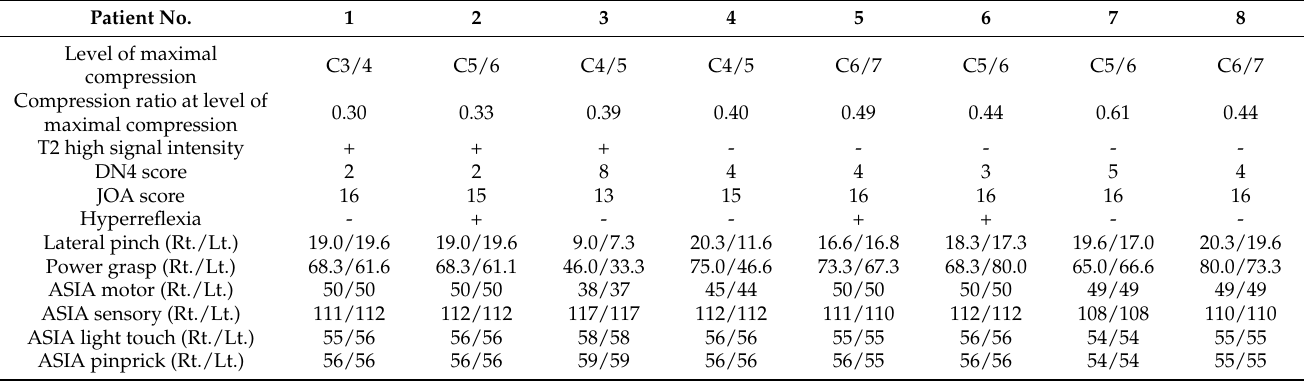
Table 1. Clinical information of the patients.